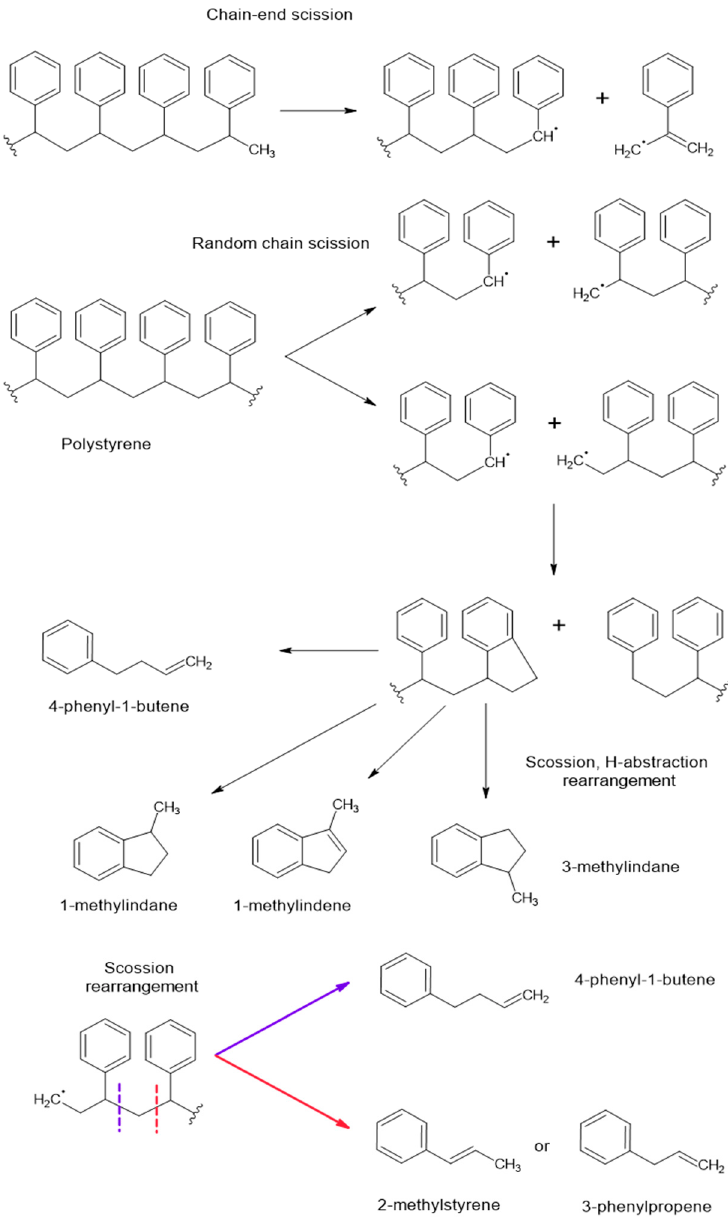
Figure 2. Schematic overview of the free-radical reactions (based on [53,54]). Table 3. Thermal degradation reactions of polystyrene during pyrolysis [54], with permission from Elsevier.